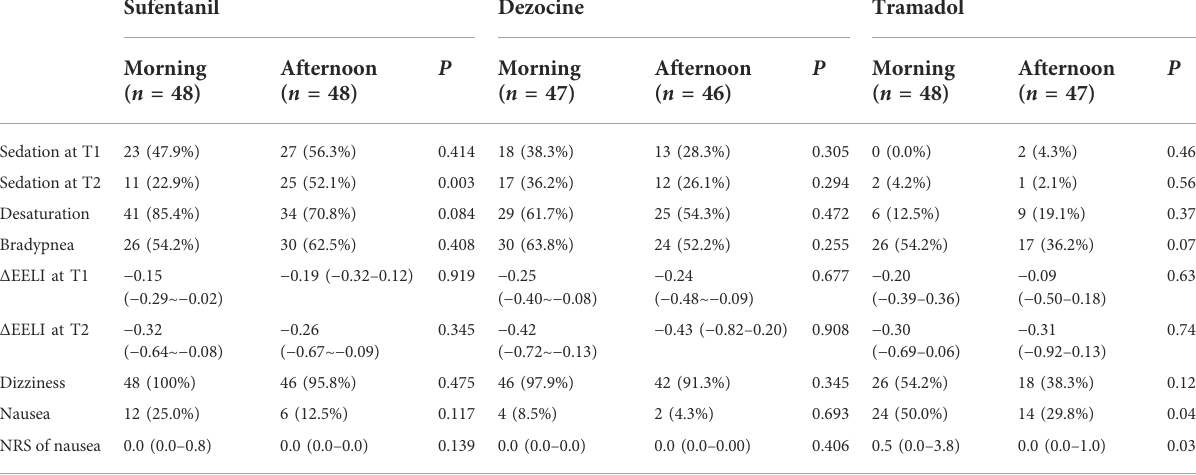
TABLE 2 Comparisons of side effects between the morning and afternoon groups after different analgesic using.